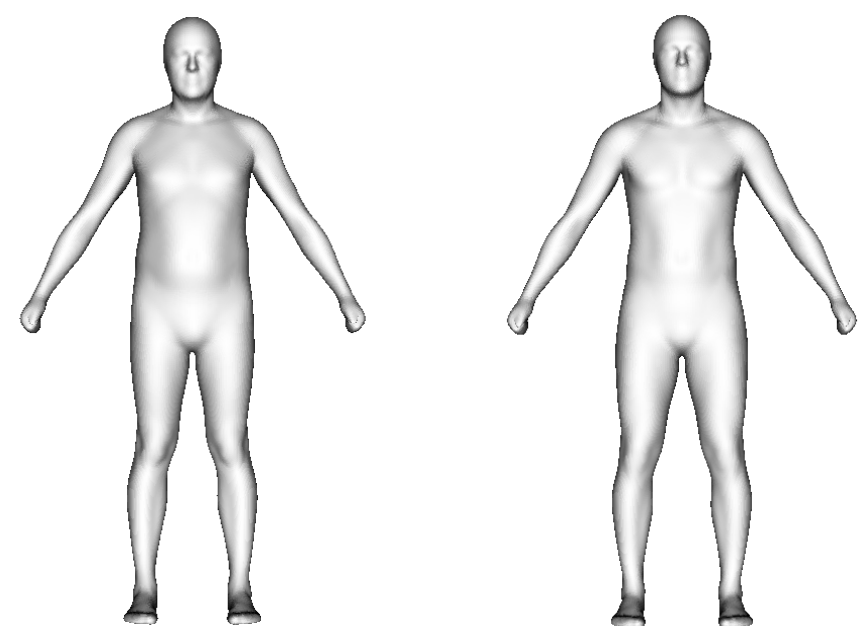
Figure 9. The weight associated with mode #6 of the statistical shape model had the highest influence in Equation (2). From visual inspection, mode #6 appears to be linked with the upper body girth and the width of the upper legs. This figure shows the +3σ (left) and −3σ (right) of mode #6.